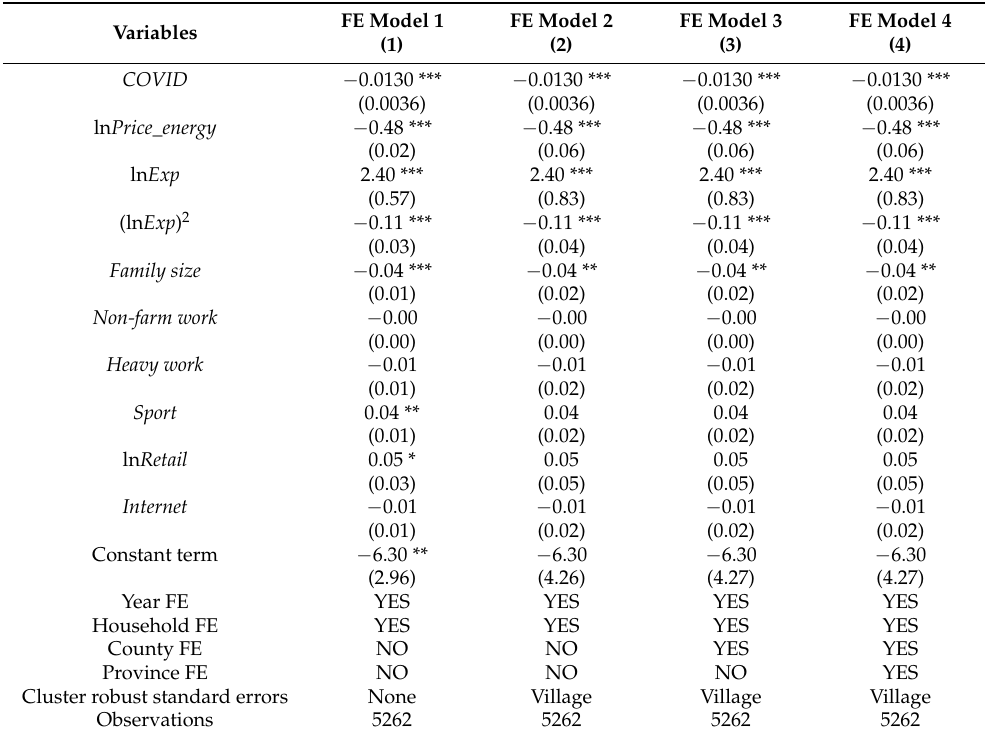
Table 3. Estimation results of the COVID-19 impact on dietary energy intake.